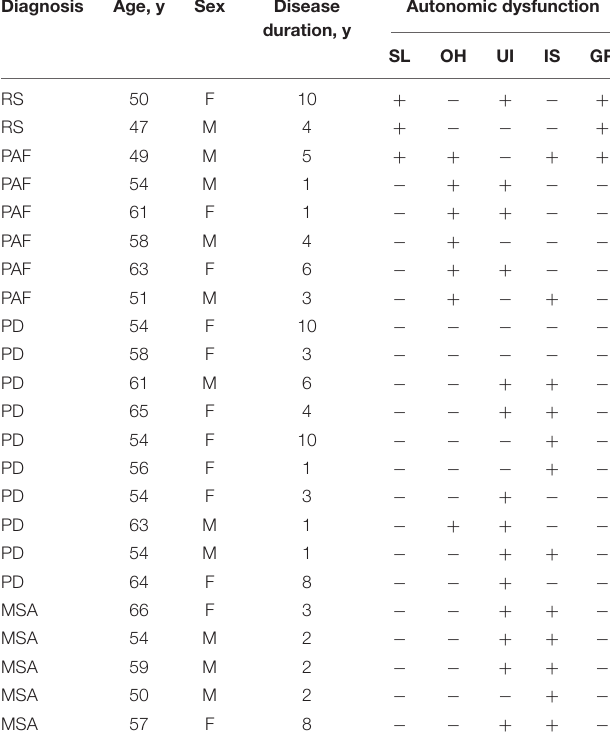
TABLE 1 | Clinical and demographic